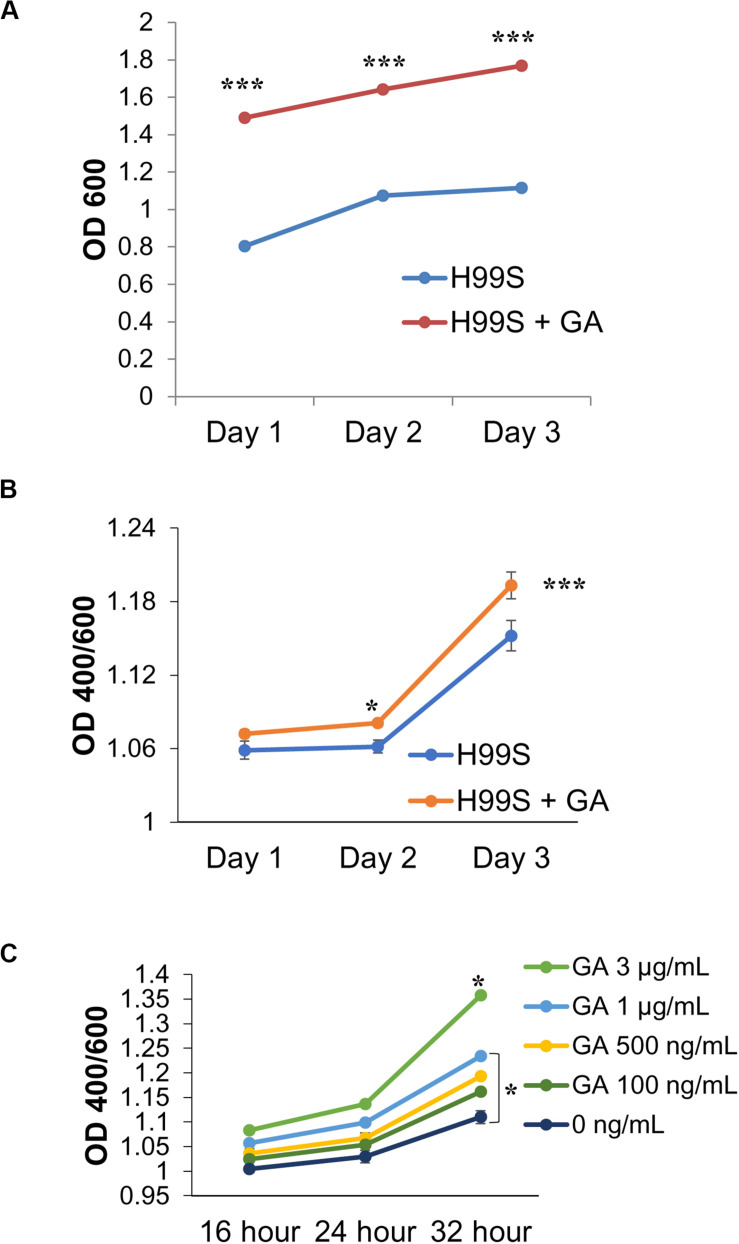
Gibberellic acid (GA) effects on C. neoformans growth and melanin production. (A) A comparison of H99S growth with and without exogenous GA (3 μg/mL). Error bars represent the standard deviation. Data is representative of three independent experiments. Statistical significance is represented as follows: ***p < 0.0001 for all days, using MANOVA with simple contrasts. Absorbances were measured at an optical density of 400 and 600 nm. (B) A comparison of H99S melanization with and without exogenous GA (3 μg/mL). Error bars represent the standard deviation. Data is representative of three independent experiments. Statistical significance is represented as follows: *p = 0.012 comparing Day 2 and ***p < 0.0001 comparing Day 3, using MANOVA with simple contrasts. Absorbances were measured at an optical density of 400 and 600 nm. (C) Dose-response of exogenous GA at various concentrations in conditioned media. Error bars represent the standard deviation. Data is representative of three independent experiments. Statistical significance is represented as follows: *p < 0.02 comparing 3 μg/mL to all other concentrations and *p = 0.01 comparing 1 μg/mL to 0 ng/mL using linear regression.